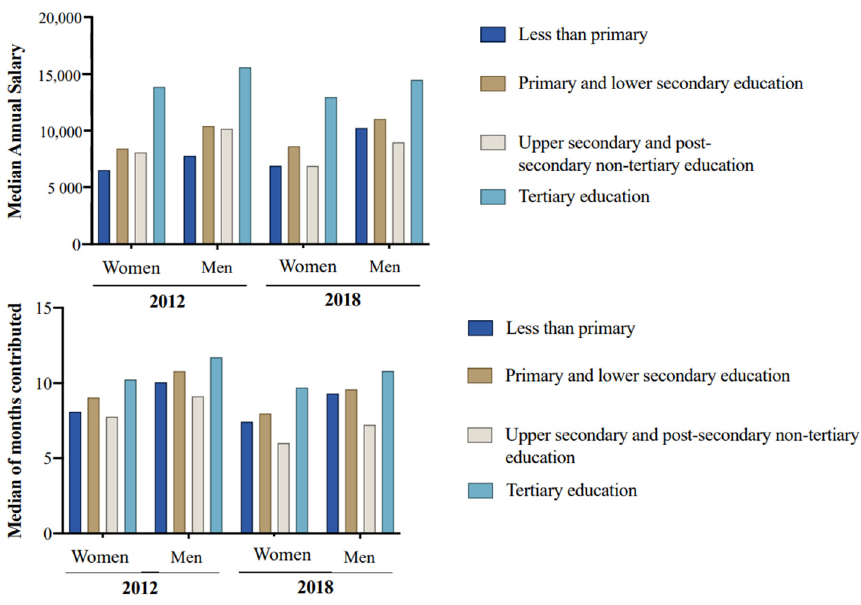
Figure 4. Median annual salary and of months contributed in people aged 20 to 30 years, Spain 2012 and 2018. Source: Our own elaboration from the Spanish CPLS 2012 and 2018.